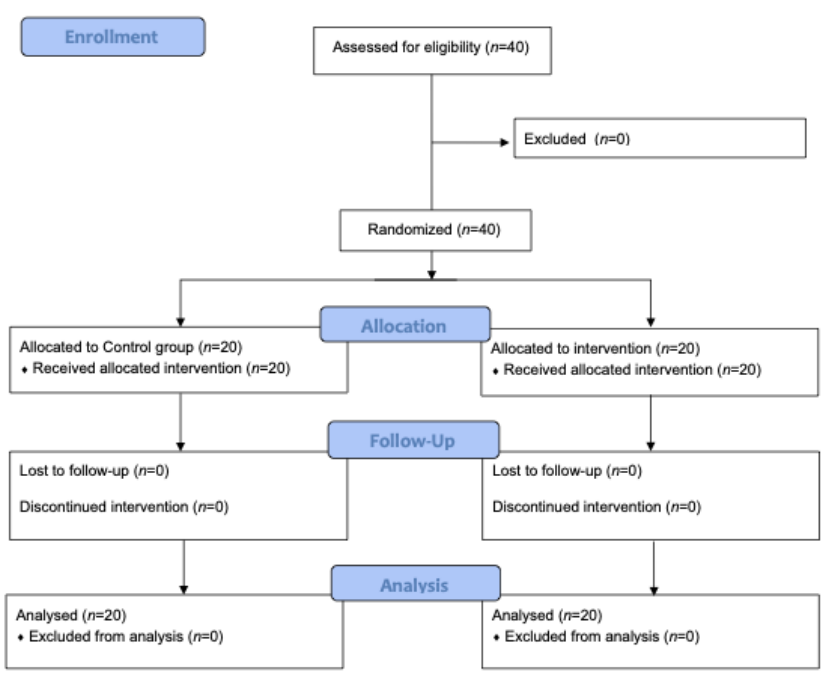
Figure 1. Consort flow diagram describing different phases of the present pilot trial.